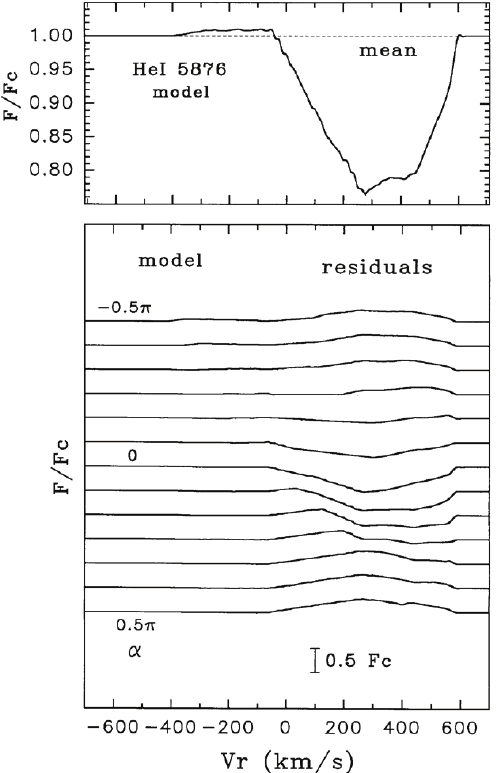
Figure 14. The same as Figure 11, but for the model described in detail in Section 6. α is an angle between the axis of the rotating stream and the line of